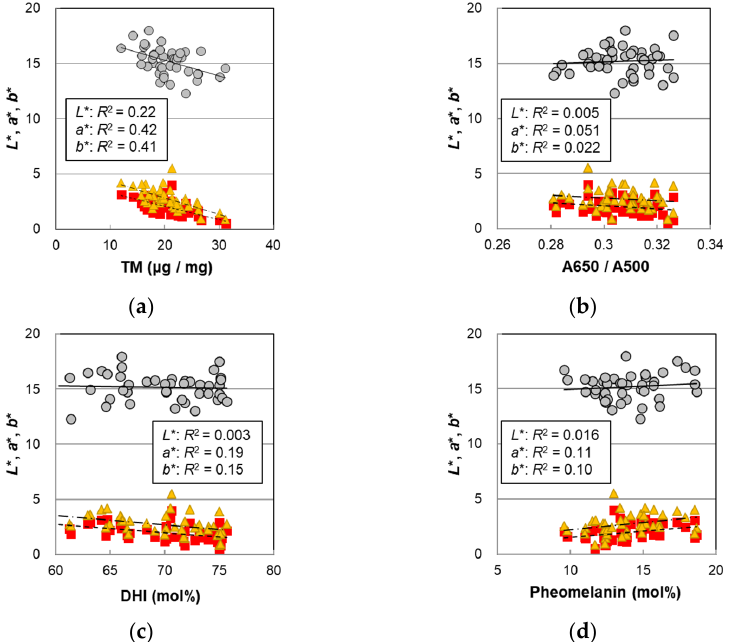
Figure 4. The hair color parameters L *, a *, and b * of the Japanese male hair samples plotted against various values measured with hair melanin analyses. Circles denote L *; squares denote a *; and triangles denote b *. Lines represent the fitted curves. Solid lines denote L *; dashed lines denote a *; and dot-and-dash lines denote b *. ( a ) The color values vs. total melanin amount, p = 0.0016 ( L *), 3.0 × 10 − 6 ( a *), and 4.6 × 10 − 6 ( b *); ( b ) the color values vs. A650/A500, p = 0.66 ( L *), 0.15 ( a *), and 0.35 ( b *); ( c ) the color values vs. DHI mol%, p = 0.74 ( L *), 0.0039 ( a *), and 0.011 ( b *); and ( d ) the color values vs. pheomelanin mol%, p = 0.42 ( L *), 0.028 ( a *), and 0.040 ( b *). The coefficients of determination are shown in each